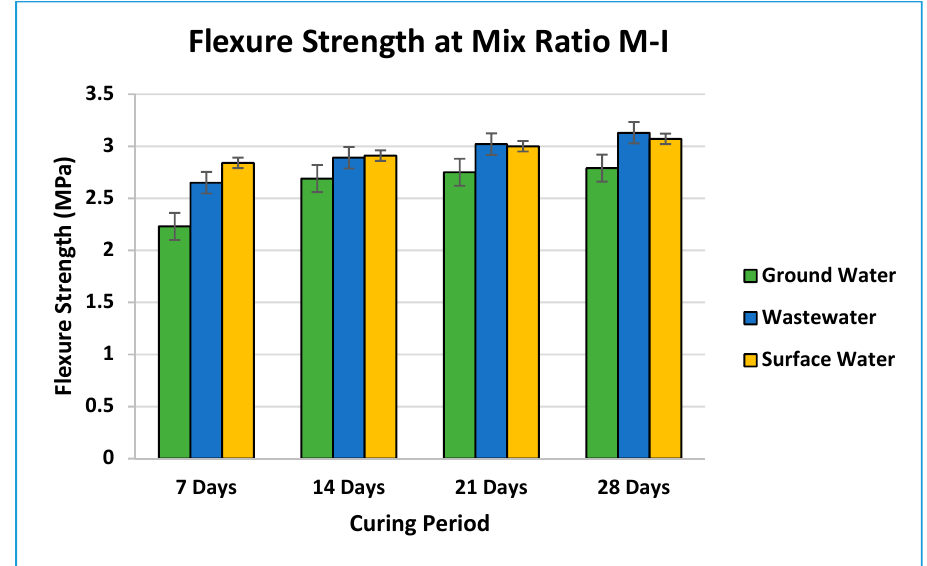
Figure 8. Flexure strength of concrete for the ratio M-I (1:2:4).